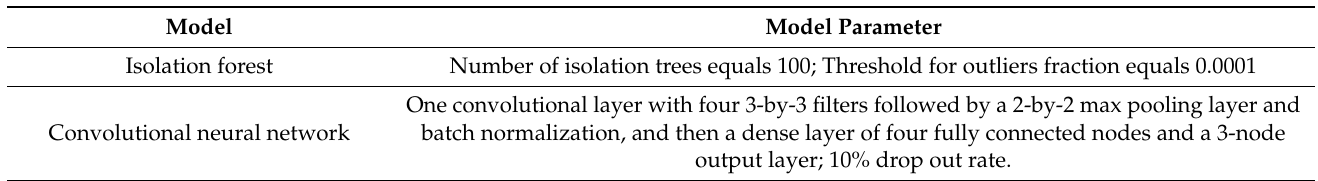
Table 1. Parameters of the trained isolation forest model (stage one) and of the convolutional neural network (stage